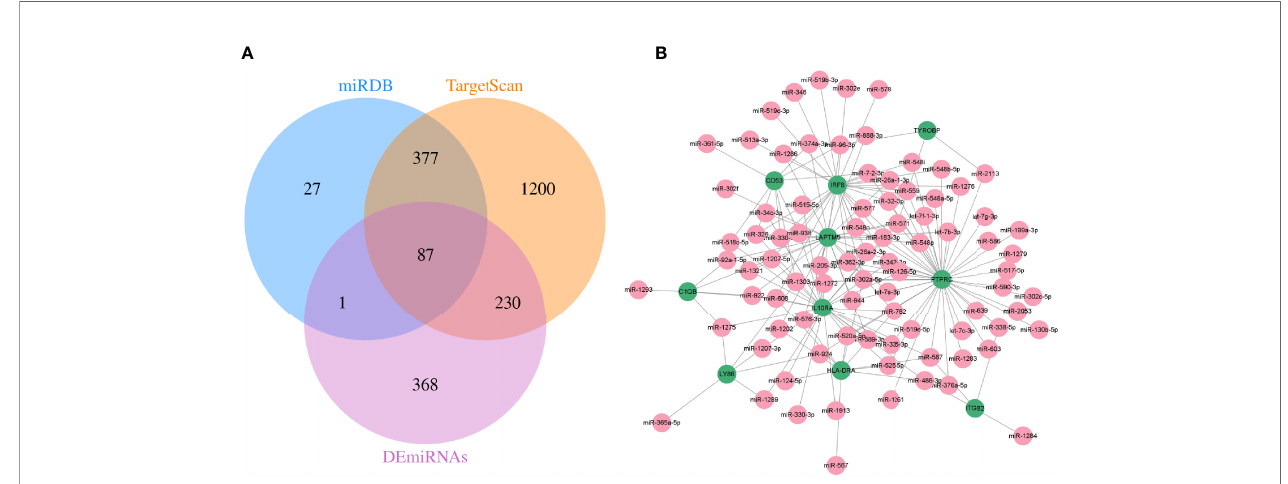
FIGURE 7 | The mRNA – miRNA network was constructed. (A) Screening of co-expressed miRNAs. (B) miRNA – mRNA regulatory network of hub genes. Green and red indicate mRNA and miRNA,